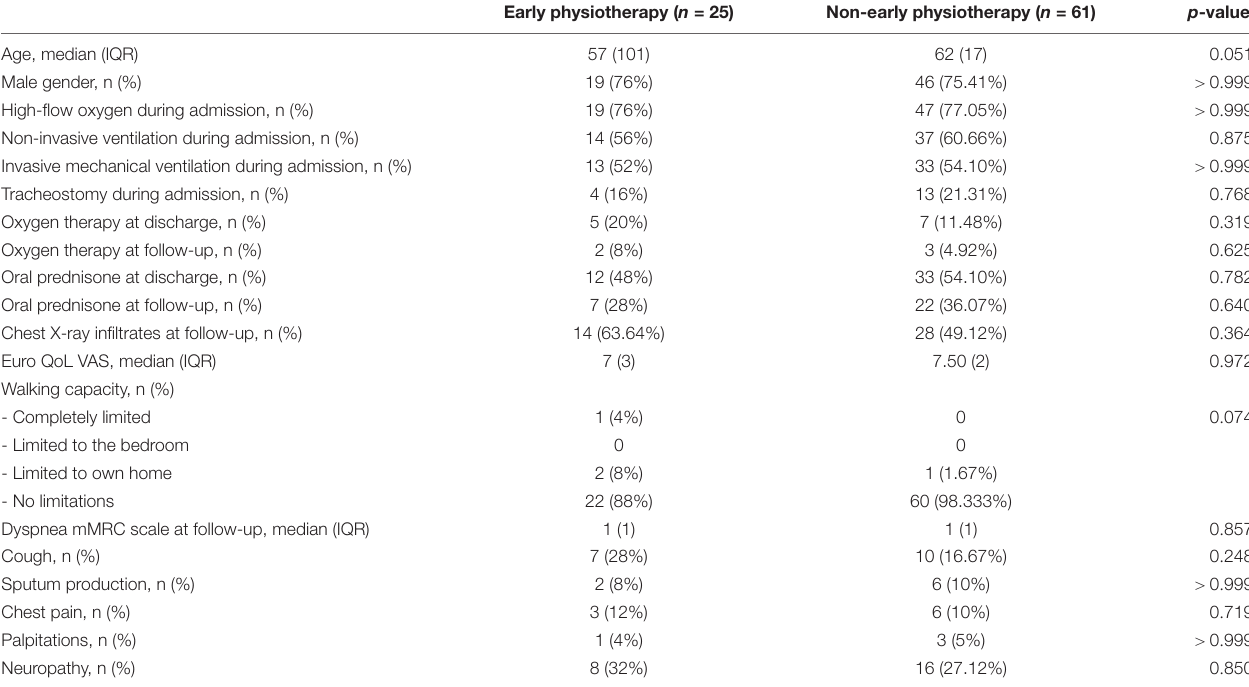
TABLE 4 | Subjects characteristics at 60 days from discharge